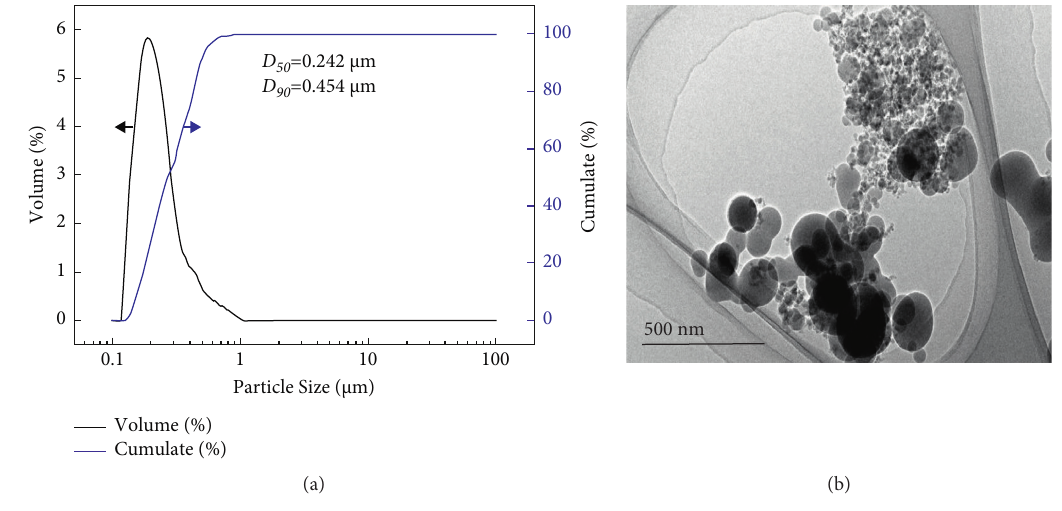
Figure 1: Particle size (a) and morphology (b) of SiO